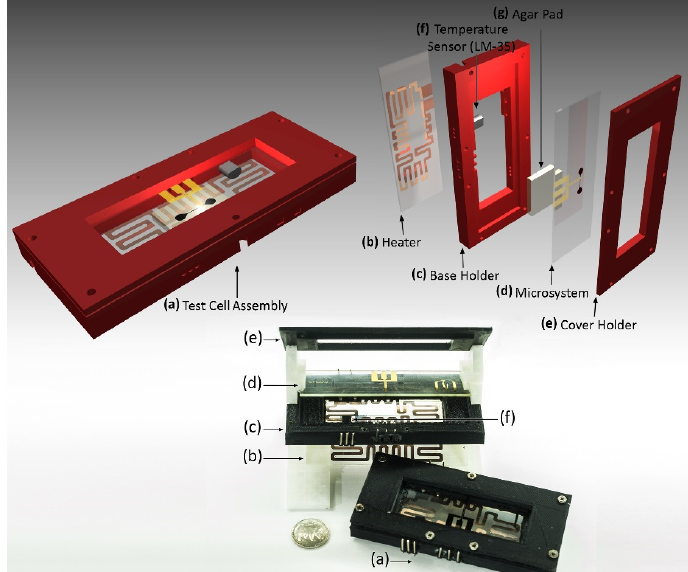
Figure 2. Test cell three-dimensional (3D) representation and photograph. ( a ) Assembly. ( b ) Copper-based glass heater. ( c ) PLA base holder. ( d ) Microsystem (microelectrodes and confinement microsystem). ( e ) PLA cover holder. ( f ) Temperature sensor (LM-35). ( g ) Agar